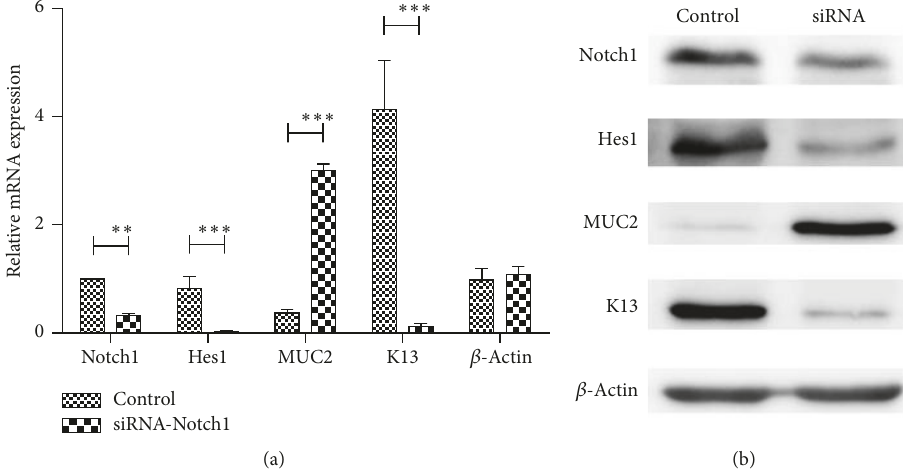
Figure 8: Effects of Notch signaling inhibition. Expressions of Notch1, Hes1, and K13 were significantly downregulated in cells transfected with Notch1-siRNA, in concert with significant increase of MUC2 expression. (a) Notch1, Hes1, K13, and MUC2 mRNA expression levels by RT-qPCR in Het-1A cells transfected with Notch1-siRNA. ∗∗ 𝑝 < 0.01 , statistically significant difference. ∗∗∗ 𝑝 < 0.001 , statistically significant difference. (b) Notch1, Hes1, K13, and MUC2 protein expressions by western blot analysis in Het-1A cells after Notch signaling inhibition by